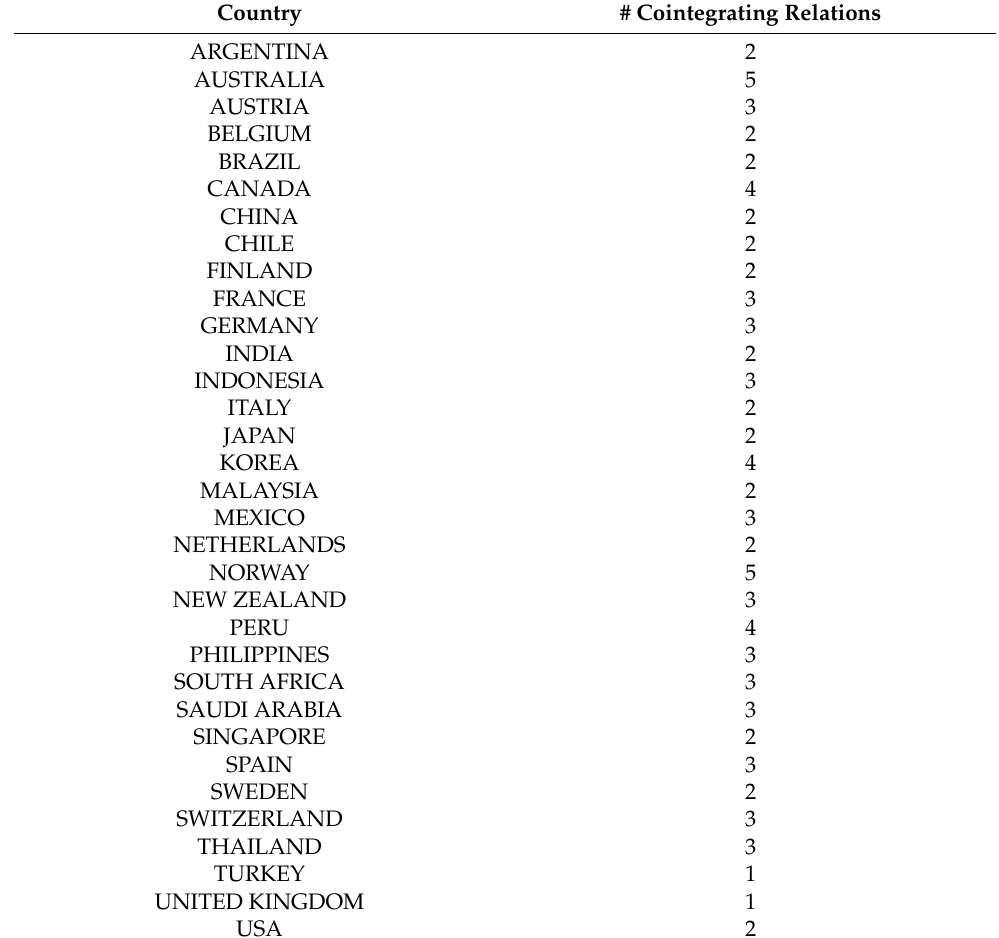
Table A2. No. of Co-integrating Relationships for the Individual VARX* Models.